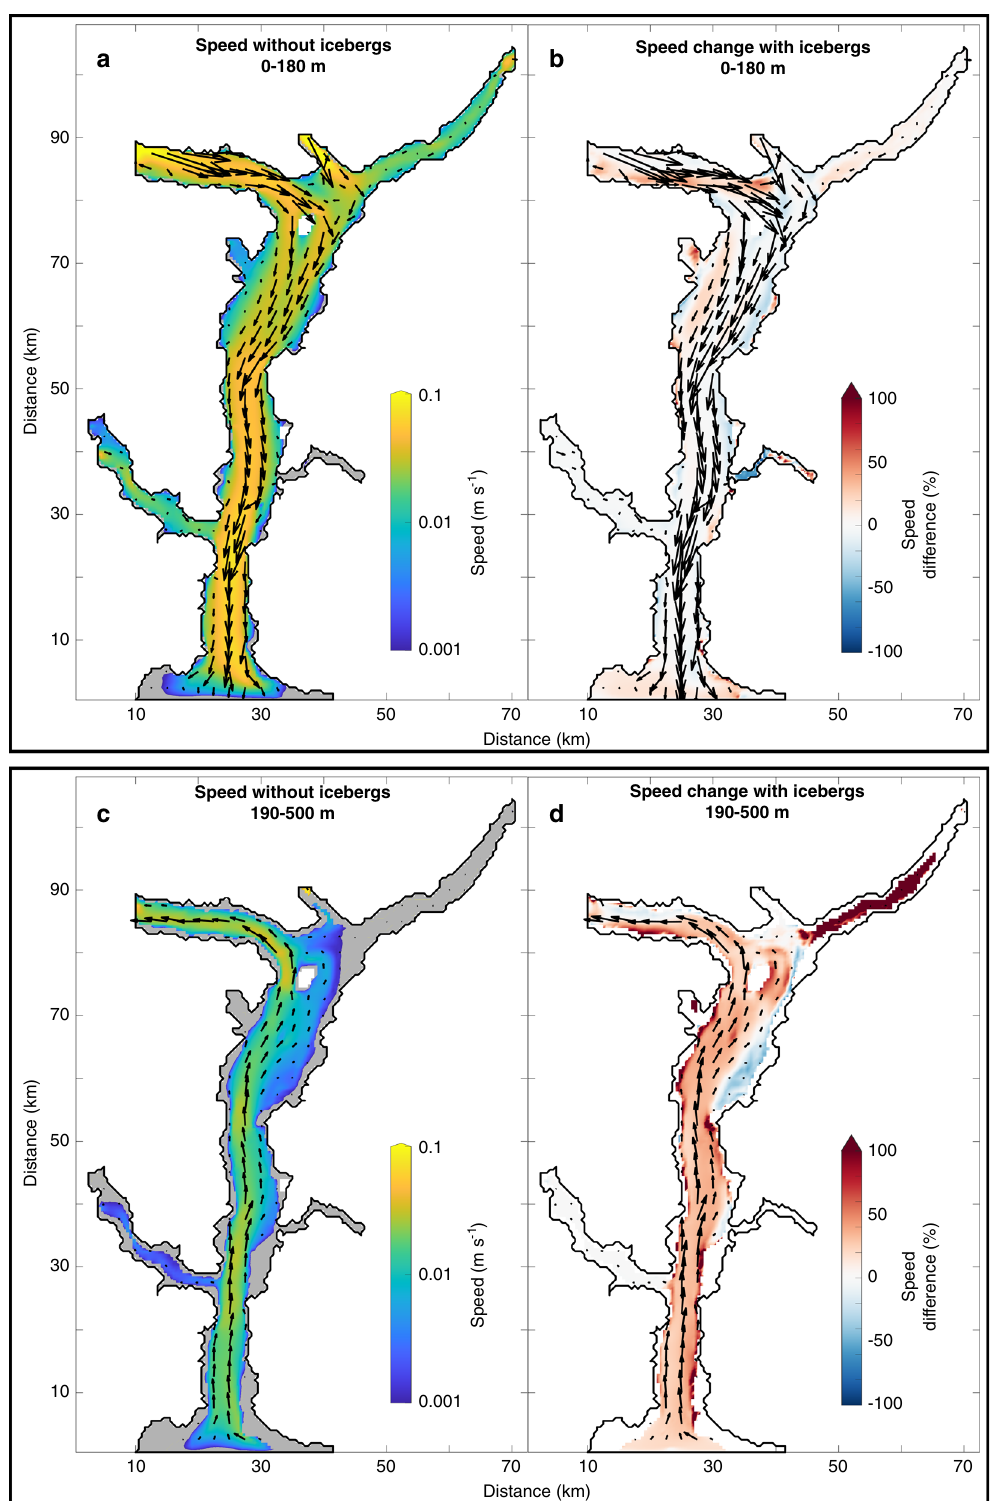
Fig. 5 The effect of icebergs on fjord circulation in our summer runoff forcing scenario. a Average current speed between 0 and 180 m depth in the no- iceberg simulation. b Relative speed change in the summer runoff forcing scenario compared to the equivalent no-iceberg simulation between 0 and 180 m depth, with positive values indicating an increase in speed. c , d As for a and b , but for the 190 – 500 m depth band. The arrows indicate the current velocity in the respective simulations averaged over the indicated depths. In all plots, the ocean boundary is at the bottom. Axis distances correspond to those in Fig.